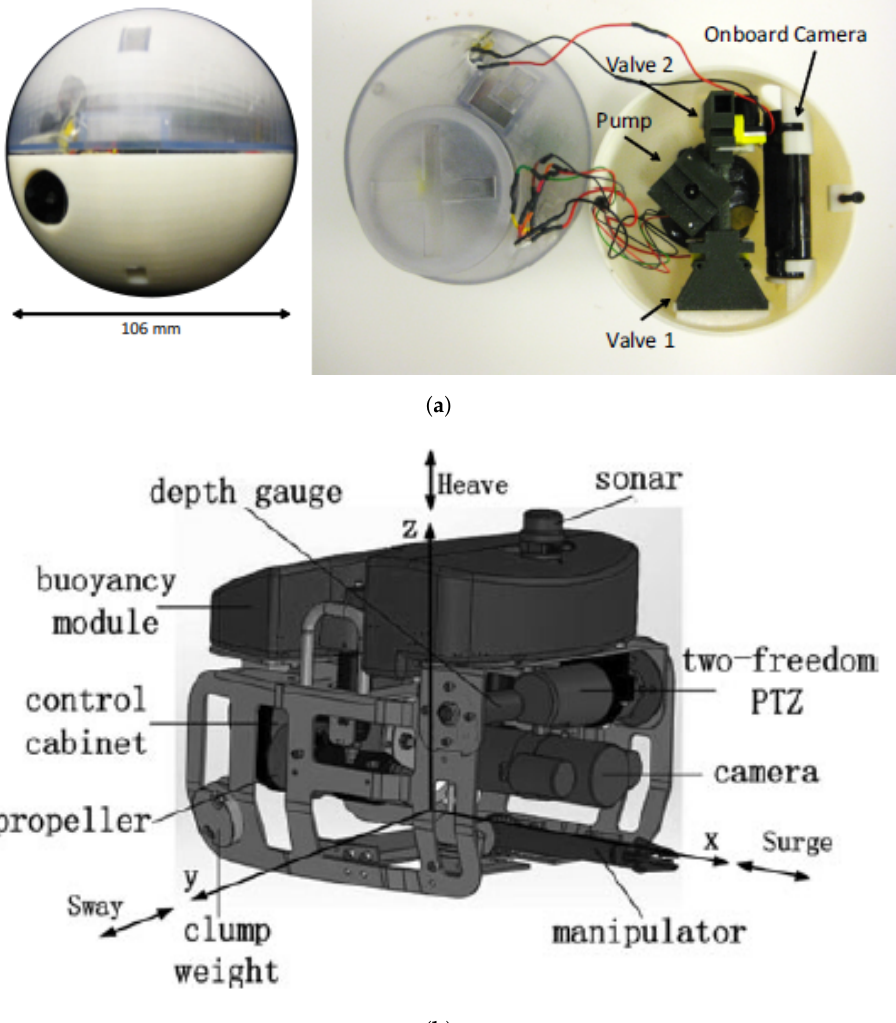
Figure 3. Examples of underwater robots developed for inspection of nuclear reactors and other water-filled infrastructures: ( a ) Spherical underwater robot. ©2013 IEEE. Reprinted, with permission, from Reference [60]. ( b ) Underwater robot prototype [62], reprinted by permission of the publisher (Taylor & Francis Ltd,